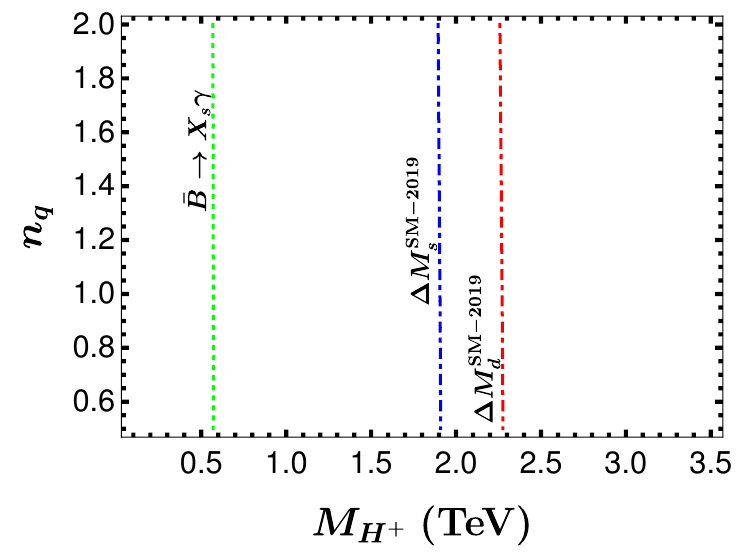
from the ¯ B → X s γ branching ratio H + / ∆ M SM , with the 2019 d,s d,s